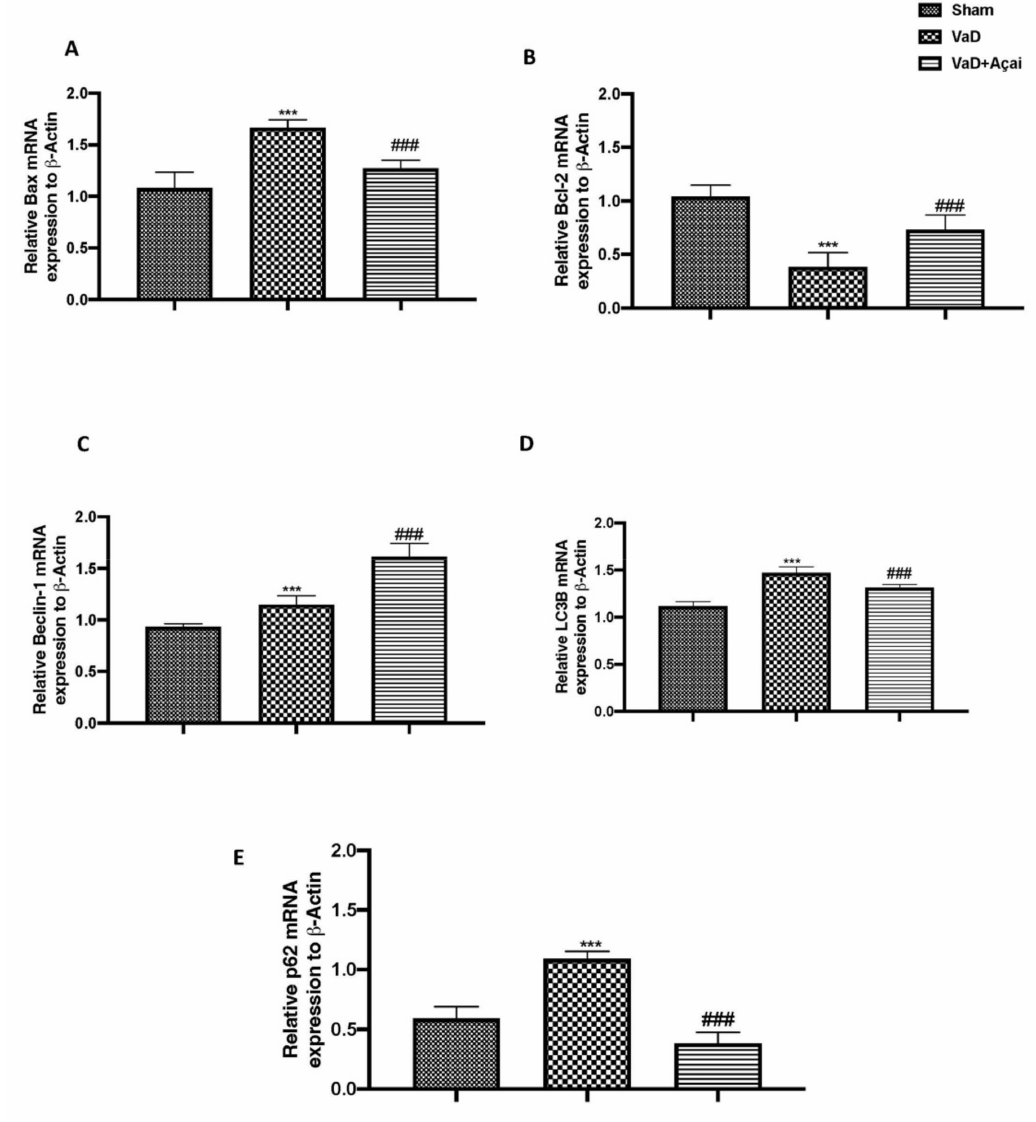
Figure 7. Açai berry modulates apoptotic and autophagic pathways. ( A ) Bax, ( B ) Bcl-2, ( C ) Beclin-1, ( D ) LC3B, ( E ) p62, mRNA levels in the hippocampus. Figures are representative from at least three experiments. Values are means ± SEM of six mice for all groups. See manuscript for further